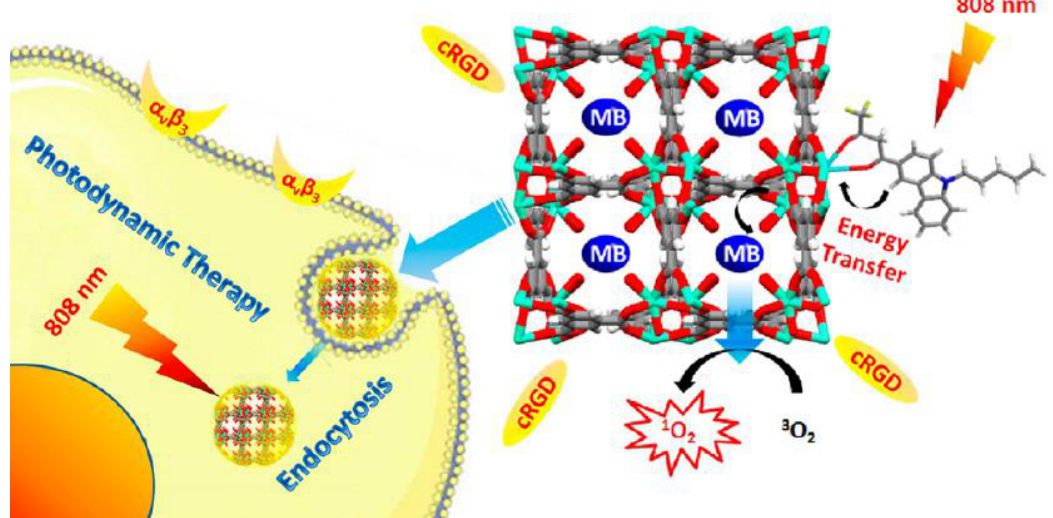
Figure 3. Schematic diagram of targeting of Eu(III) -based nanoscale metal organic framework to the tumor site and realized photodynamic therapy under the excitation of 808 nm near infrared light [20]. Reprinted (adapted) with permission from (Functionalized Eu(III)-Based Nanoscale Metal–Organic Framework To Achieve Near-IR-Triggered and -Targeted Two-Photon Absorption Photodynamic Therapy). Copyright (2018) American Chemical Society.